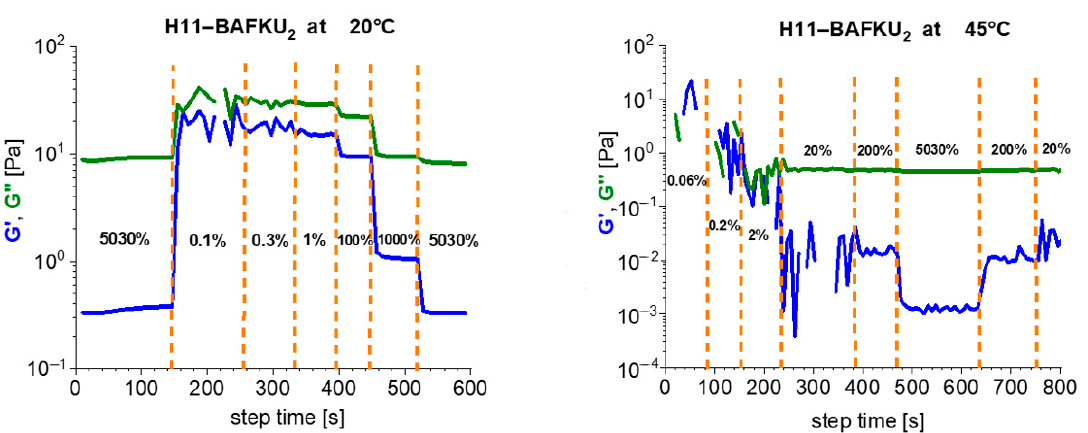
Figure 10. Exemplary thixotropy tests carried out on the copolymer H11–BAFKU 2 at 20 ◦ C ( a ) and 45 ◦ C ( b ); the tests were performed after a preparatory procedure, which consisted in heating up to the isotropic state (at 80 ◦ C), followed by cooling down to the experiment temperature and waiting 5 min for equilibration (during which no deformation occurred); the thixotropy tests were conducted as rheological time sweeps conducted in several subsequent stages di ff ering in the value of the applied constant deformation (strain)